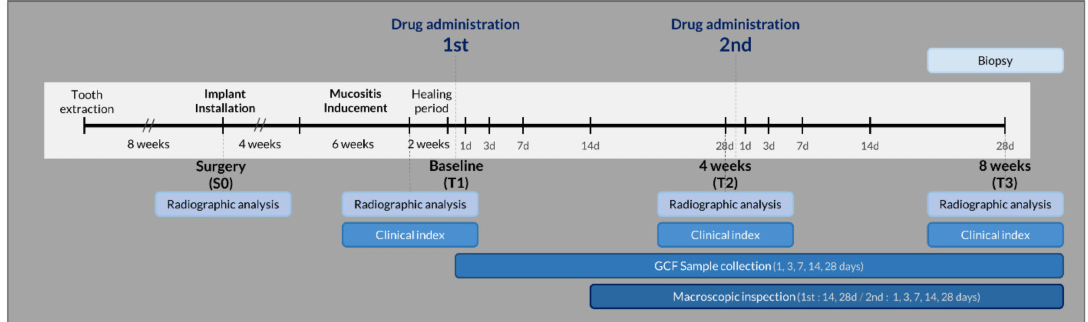
Figure 1. Study outline.